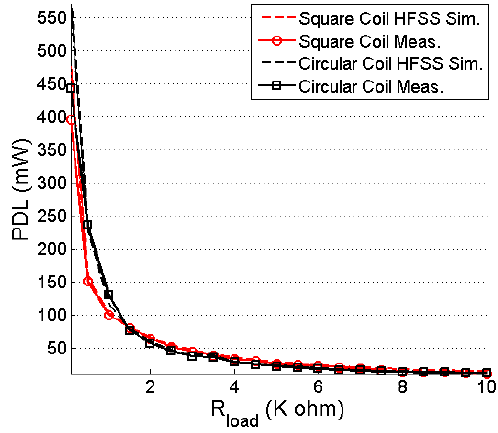
Figure 20. PDL versus R load . Table 5. Comparison with Previous Work.